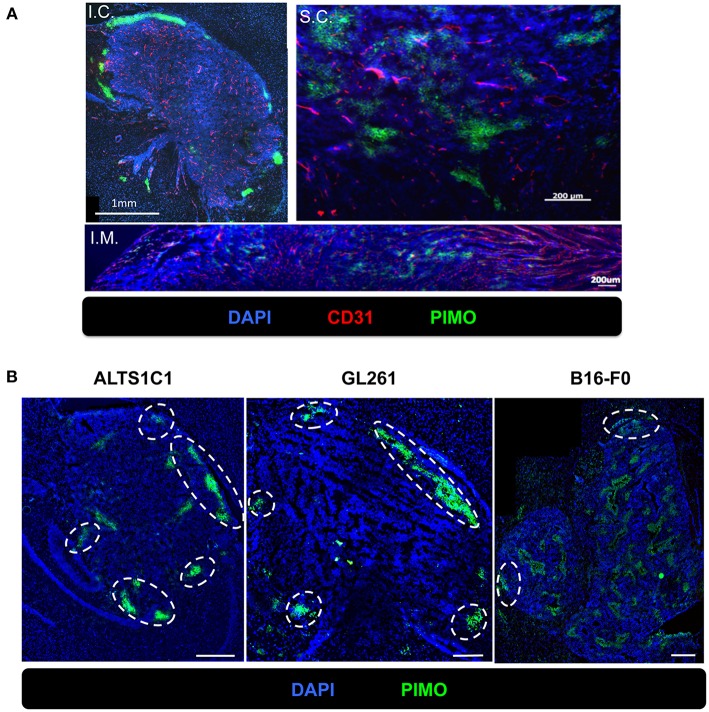
The peripheral hypoxia was a unique phenomenon in orthotopic tumors and independent of tumor types. (A) The distribution of hypoxia (green) and vessels (red) was assessed on the ALTS1C1 tumors grown intracranially (I.C.), intramuscularly (I.M.) and subcutaneously (S.C.). Nucleus staining with DAPI was shown in blue. (B) Three types of tumor cells, ALTS1C1 (astrocytoma), GL261 (glioma), and B16-F0 (melanoma), were inoculated orthotopically and tumor hypoxia was assessed by PIMO staining. Tumor peripheral hypoxia was circled by white dot line. Scale bar = 400 μm.